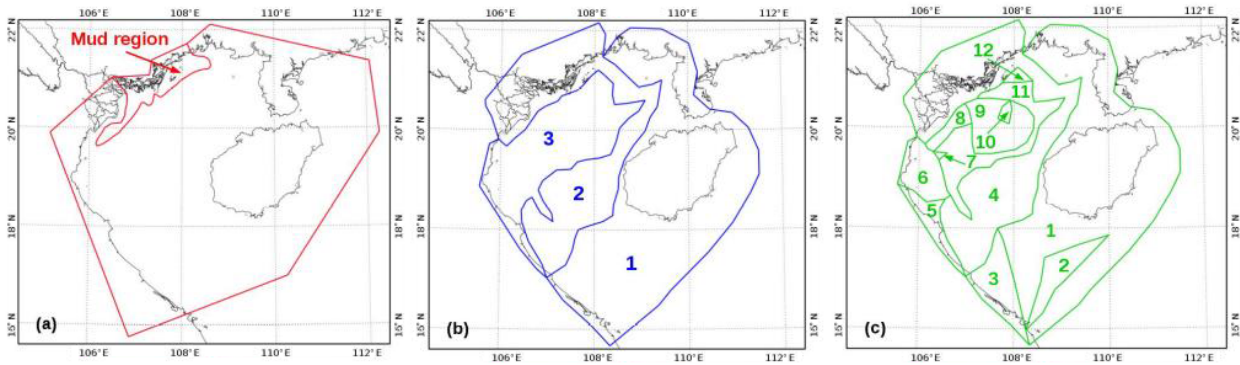
Figure 12. Spatial partitioning of the domain for the set of experiment SET3 (a) , for SET4 (b) , and for SET5 (c) .